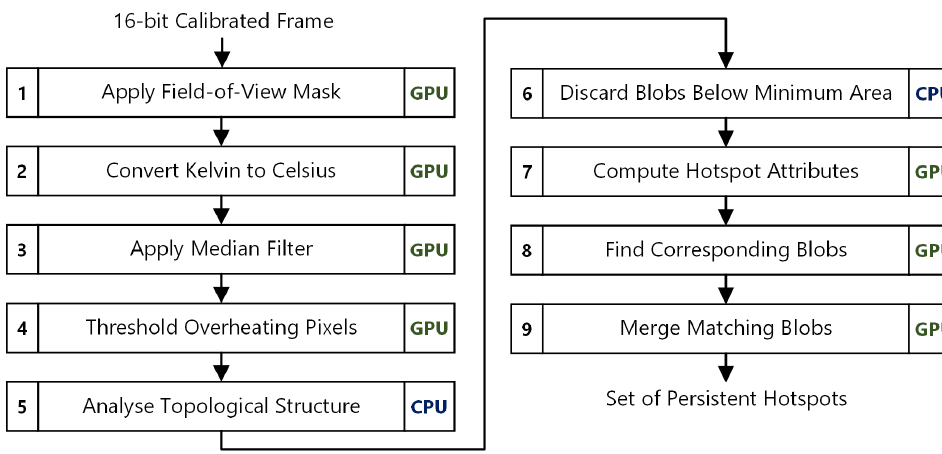
Figure 6. Overload hotspot detection pipeline.